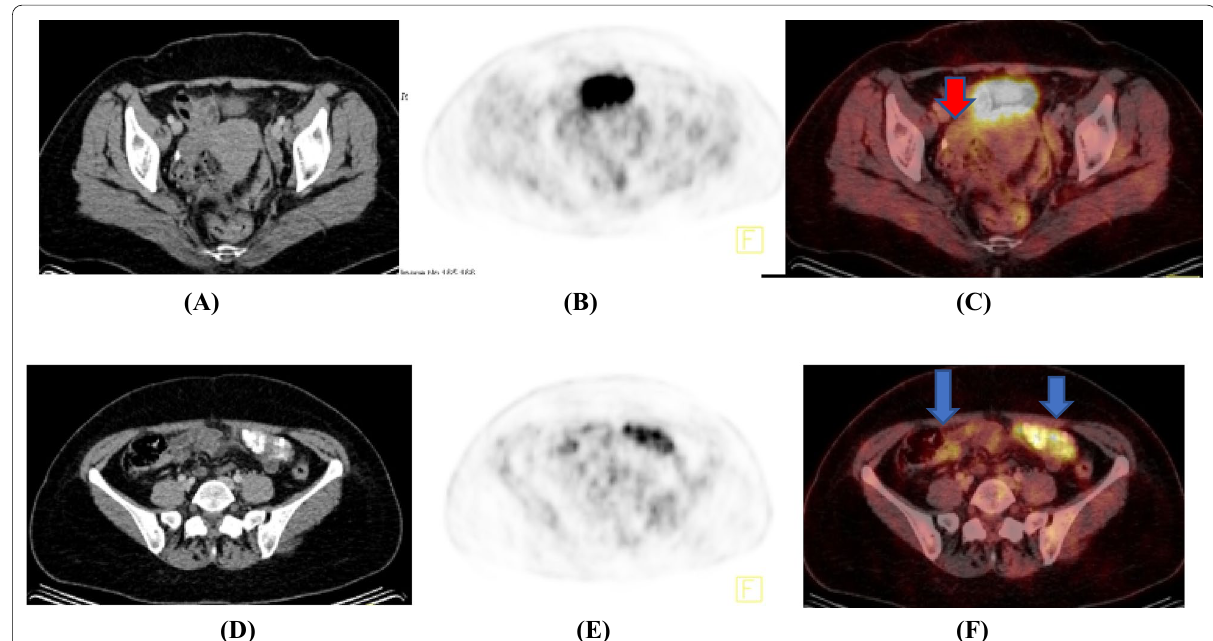
Fig. 4 1st pre management study A – C Axial CT, PET and PET/CT scan showing right complex neoplastic solid and cystic adnexal mass lesion (red arrow) measuring 5.5 3 cm with SUVmax 3.2, D – F Axial CT, PET and PET/CT scan showing multiple calcified metastatic ominto‑peritoneal deposits × at LV5 level (blue arrows) measuring up to 2 cm with SUV max 4.5 =